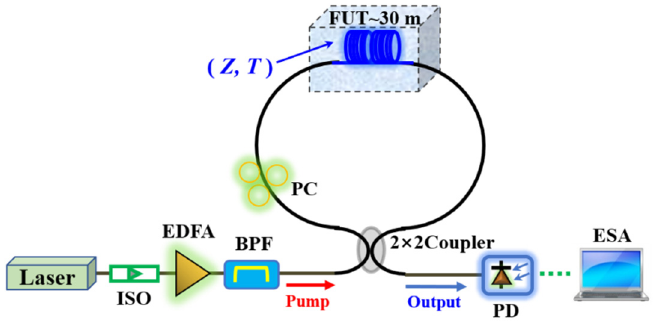
Figure 7. Experimental setup for observing BGS and FBSS in the MSI 2-LP-mode fiber.